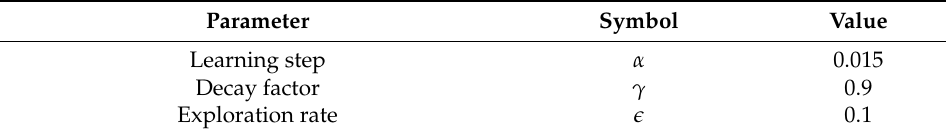
Table 3. Parameters related to the TD method.